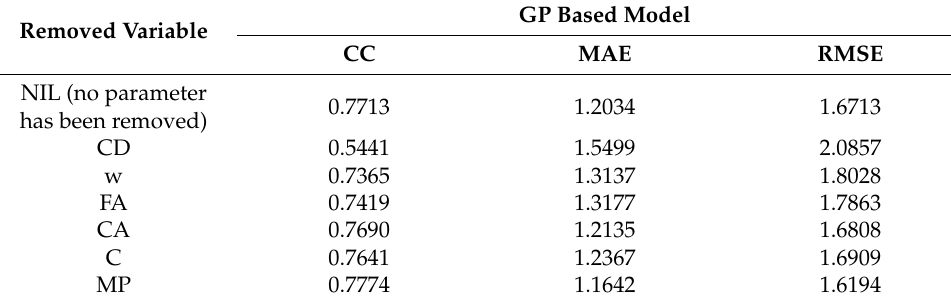
Table 12. GP-based sensitivity model